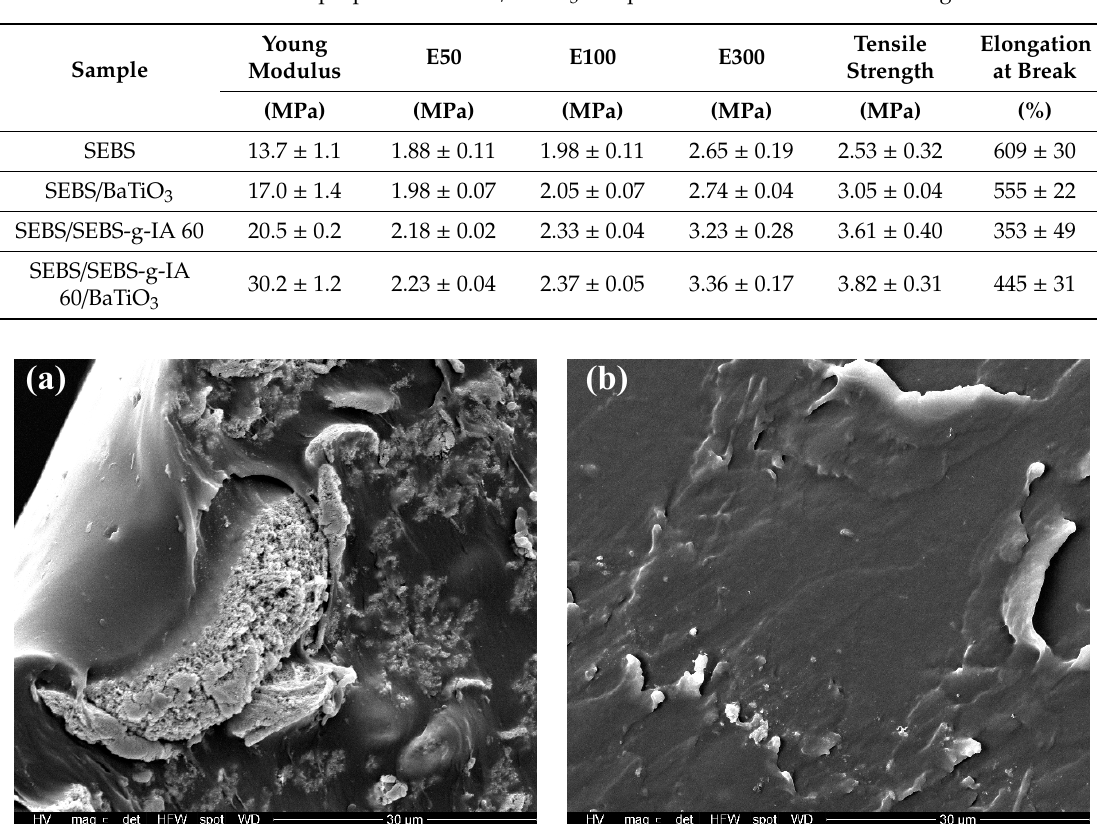
Figure 6. SEM images of SEBS/BaTiO 3 20 ( a ) and SEBS/SEBS-g-IA 60/BaTiO 3 20 ( b ).